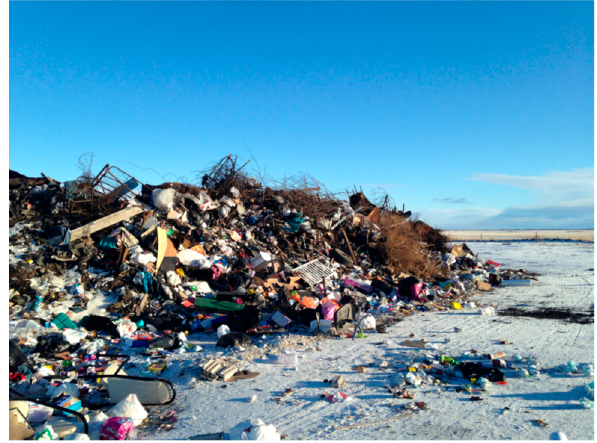
Figure 4. Landfill on First Nation in Treaty 6 territory. Photo credit: R. Patrick.